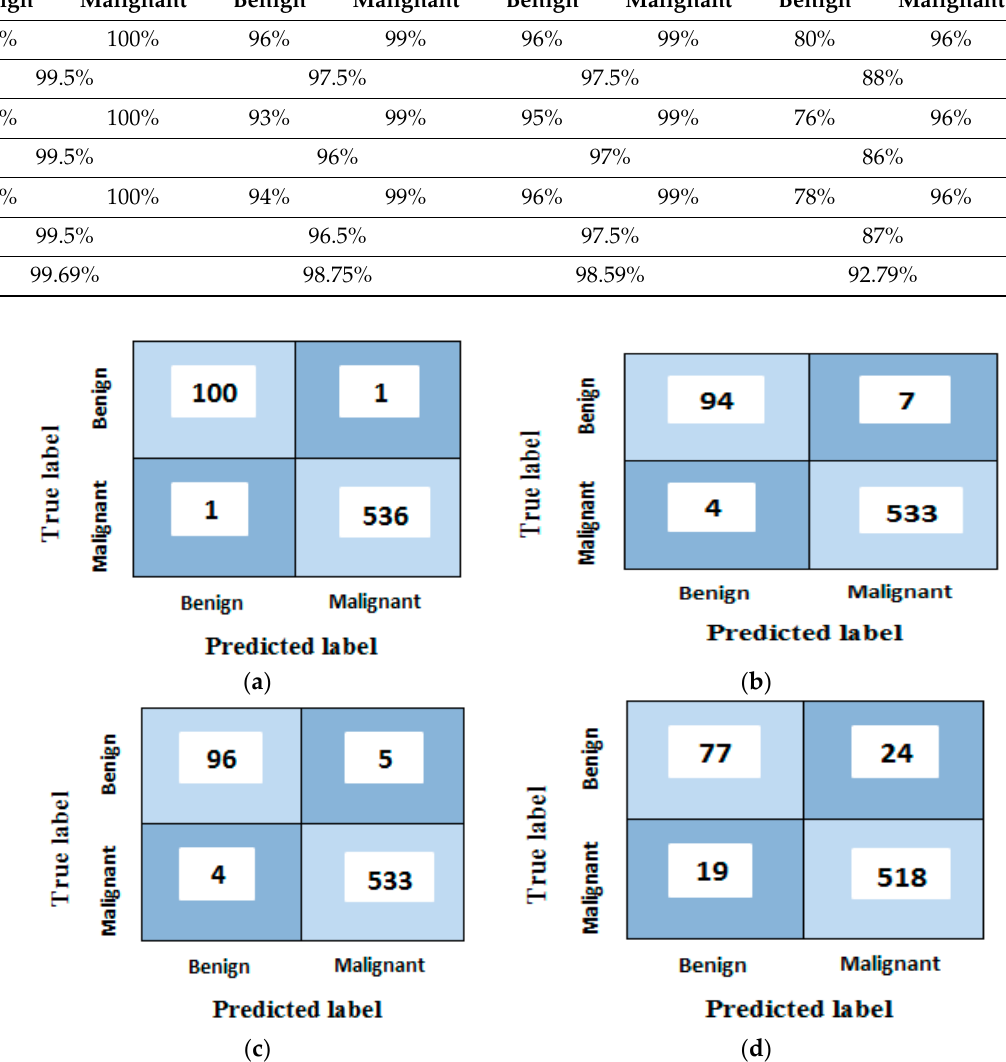
Figure 13. Confusion matrices analyses of the proposed model for ( a ) random forest, ( b ) support vector machine, ( c ) k ‐ nearest neighbor and ( d ) naïve Bayes classifiers after using grey wolf optimization algorithm.